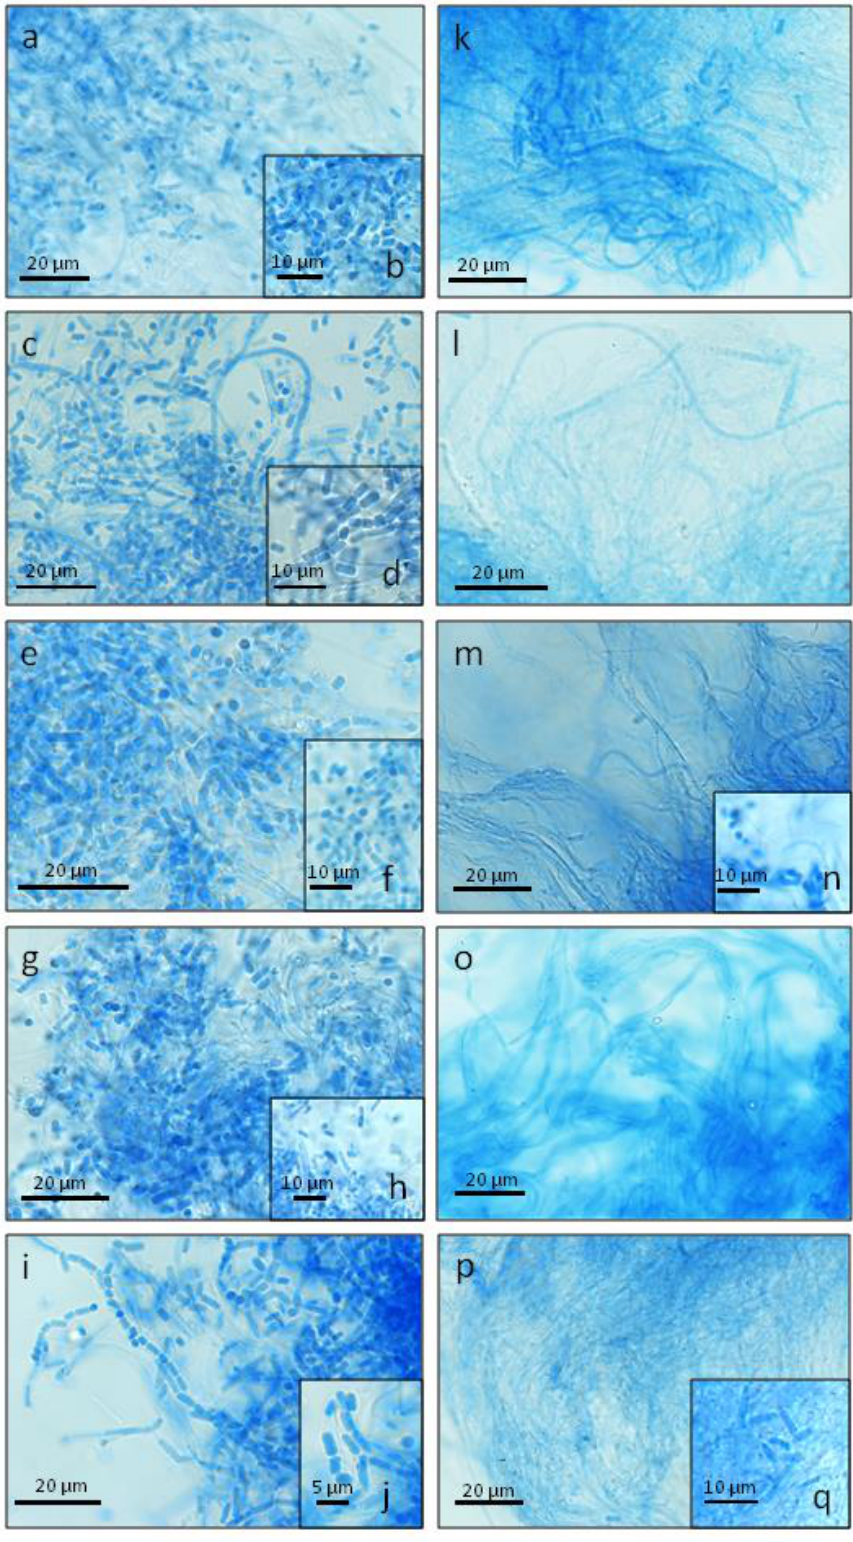
Figure 2. Confocal laser scanning micrographs of 5-day-old Cerrena unicolor cultures growing on 1.5% agar ash sawdust medium in white ( a , b ), dark ( c , d ), red ( e , f ), blue ( g , h ), and green ( i , j ) light conditions; Confocal laser scanning micrographs of 5-day-old C. unicolor cultures growing on ash sawdust medium in white ( k ), dark ( l ), red ( m , n ), blue ( o ), and green ( p , q ) light conditions.